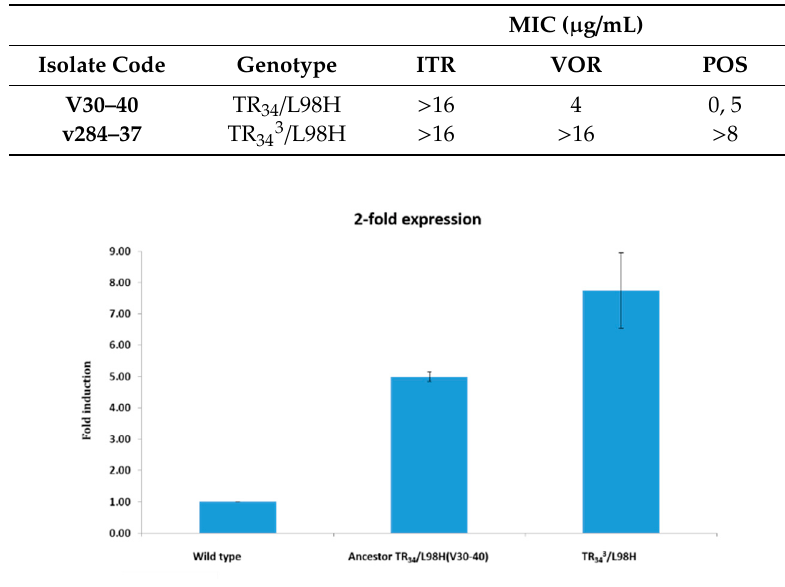
Figure 3. Expression of cyp51A in the TR 343 /L98H isolate, compared with the TR 34 /L98H ancestor and a wild type (WT) control isolate.